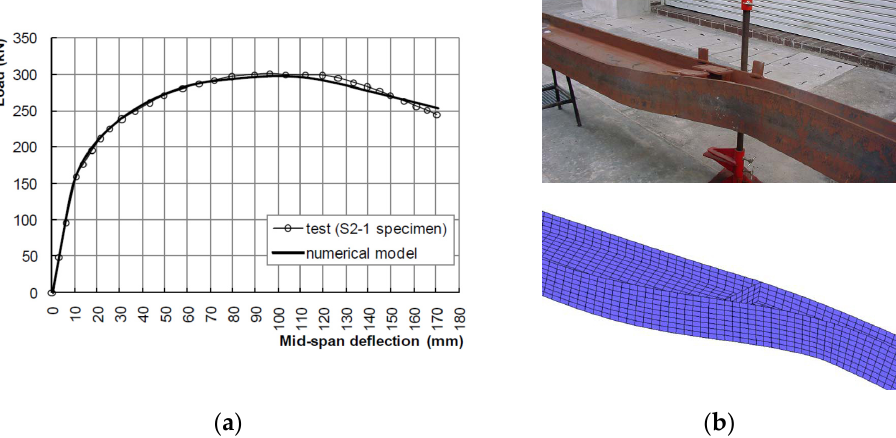
Figure 3. ( a ) Comparison of the numerical analysis results with the test results for the specimen S2-1 at 415 °C; ( b ) deformed shape of the steel beam at failure.